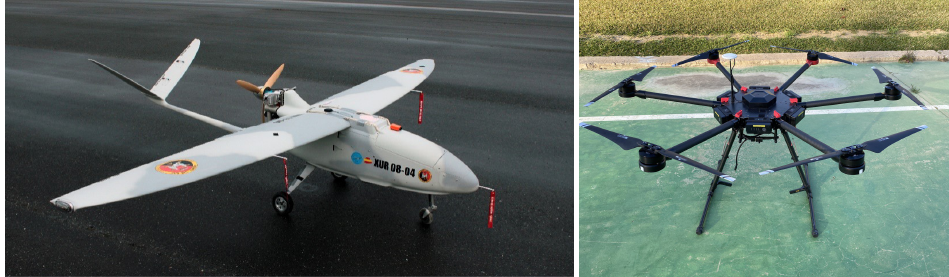
Figure 2. The Atlantic I ( left ) and DJI M600 ( right ) UAS will be used to validate the UTM functionali- ties developed in the GAUSS